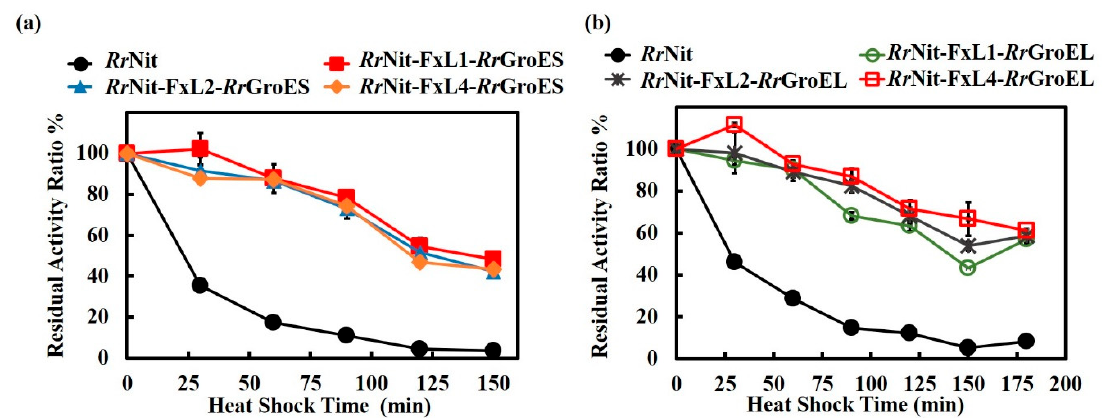
Figure 3. Heat inactivation curves of engineered E. coli cells containing chaperone-fused nitrilase with different linkers. ( a ) Nitrilase- Rr GroES fusion enzyme in BL21(DE3) (pET28a- Rr Nit-FxL1- Rr GroES), BL21(DE3) (pET28a- Rr Nit-FxL2- Rr GroES) and BL21(DE3) (pET28a- Rr Nit-FxL4- Rr GroES) cells. unmodified nitrilase in BL21(DE3) (pET28a- Rr Nit) was used as a control. ( b ), Nitrilase- Rr GroEL fusion enzyme in BL21(DE3) (pET28a- Rr Nit-FxL1- Rr GroEL), BL21(DE3) (pET28a- Rr Nit-FxL2- Rr GroEL) and BL21(DE3) (pET28a- Rr Nit-FxL4- Rr GroEL) cells. Unmodified nitrilase in BL21(DE3) (pET28a- Rr Nit)